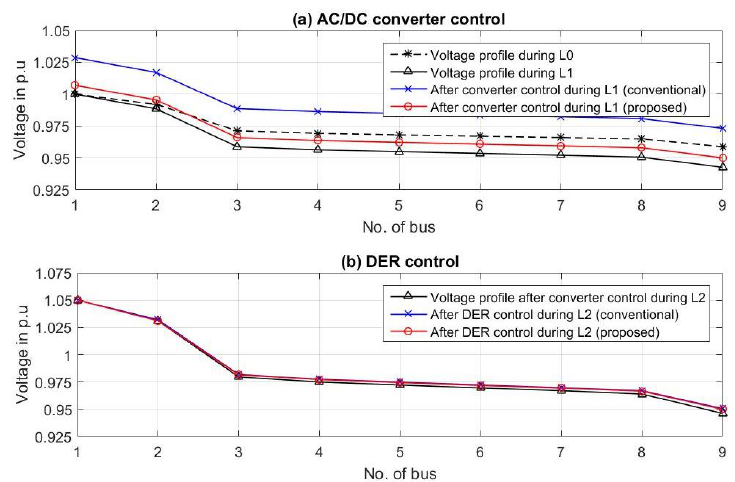
Figure 11. Voltage profile of the LVDC system under voltage control methods (Case 1). (a) with AC/DC converter control; (b) with distributed energy resource control after AC/DC converter control.